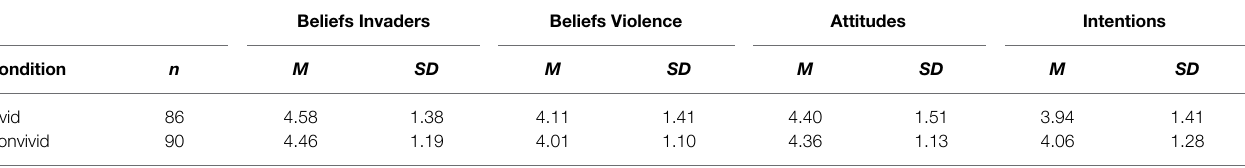
TABLE 3 | Properties of study outcomes by narrative